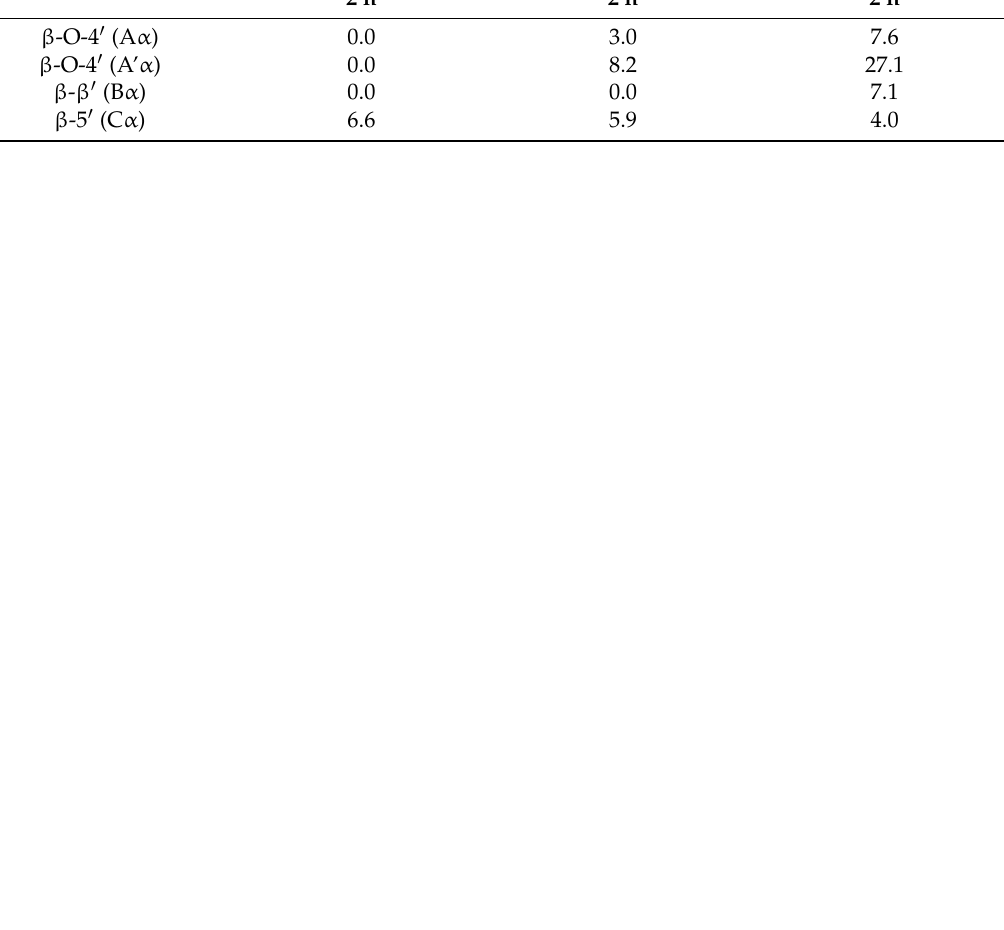
Table 2. The number of linkages per 100 aromatic units present in lignin extracted after acid methanolysis at 180 ◦ C, at different acid loadings, methanol/biomass ratios ( w / w ) and reaction times. Number of Linkages Per 100 Aromatic Linkage